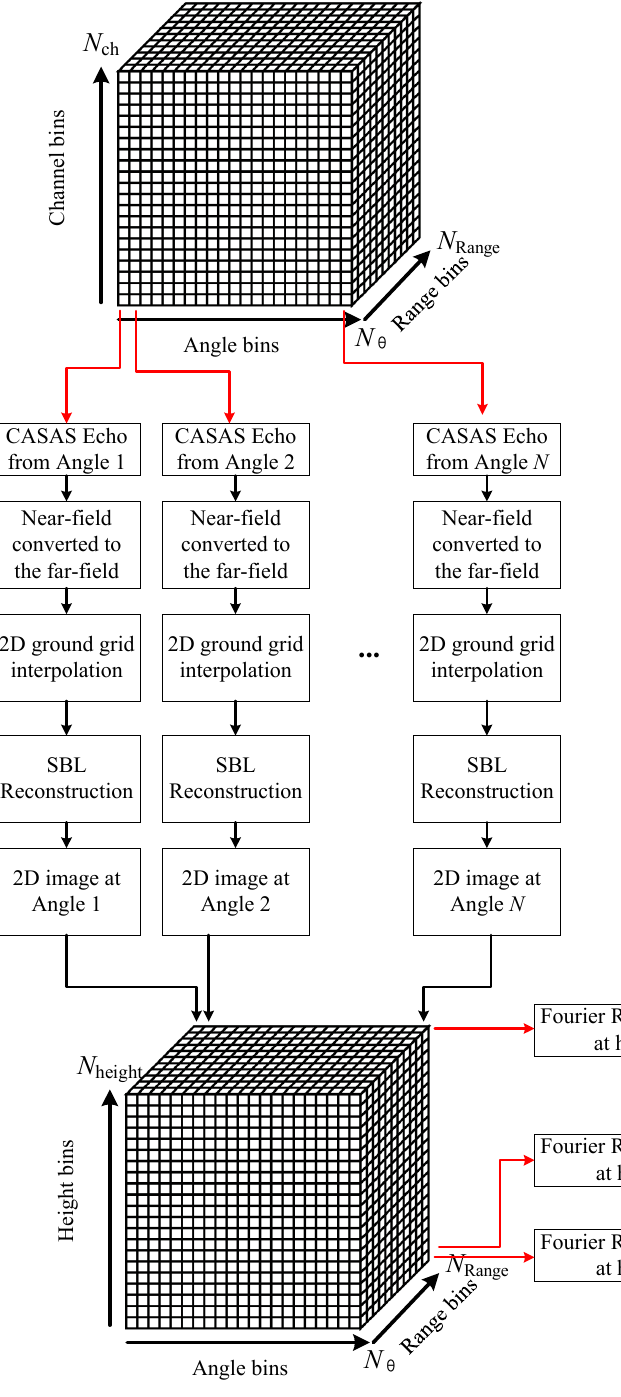
Figure 3. The 3D imaging flowchart of circular array synthetic aperture sonar.